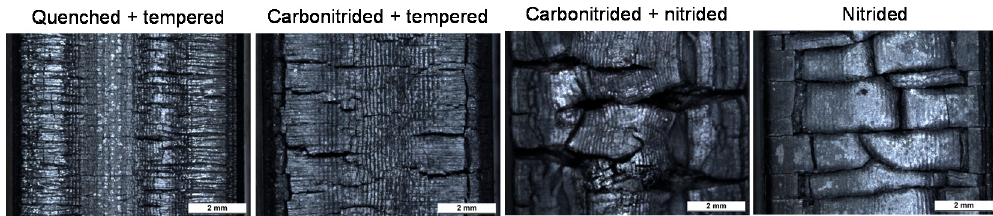
Figure 10. Surface of the different heat-treated specimens after 100 cycles of induction heating and quenching.